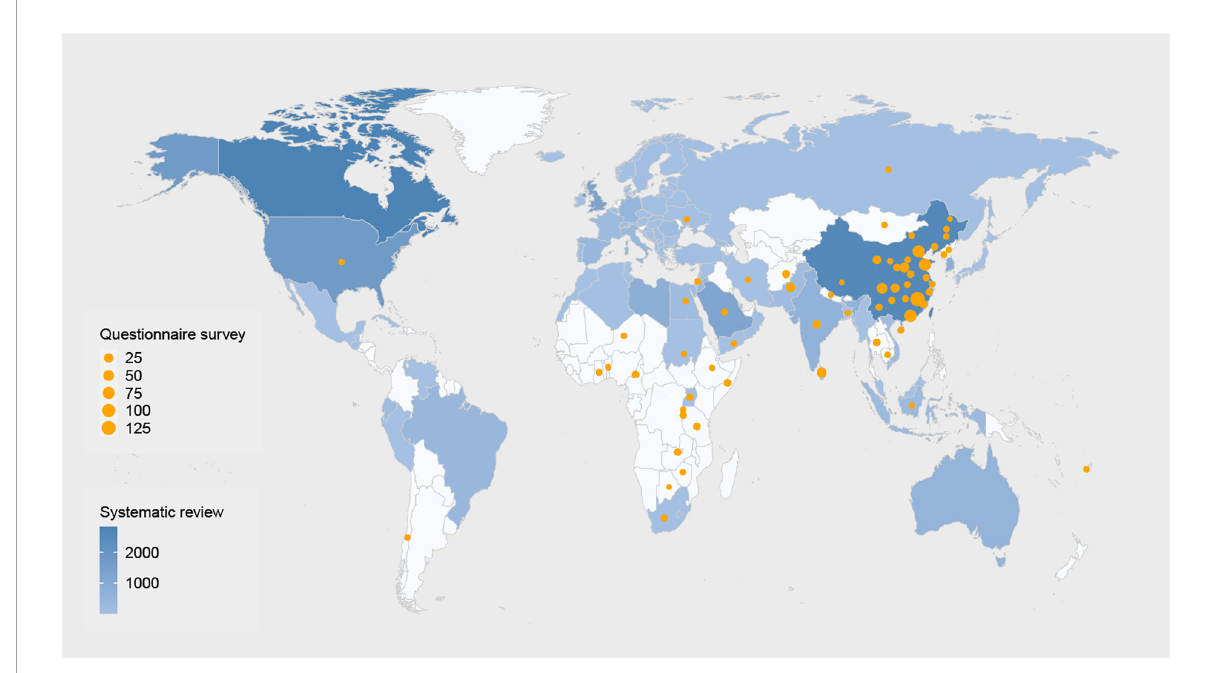
FIGURE2 Geographic distribution of participants in the systematic review and the survey. The blue indicates the number of participants of studies included in the systematic review. The darker the color, the more participants. The orange dots indicate the number of participants in our questionnaire survey. The larger the dots, the more participants. Studies without providing specific locations are not shown in the figure. Please see Table 1 for detailed number and locations of